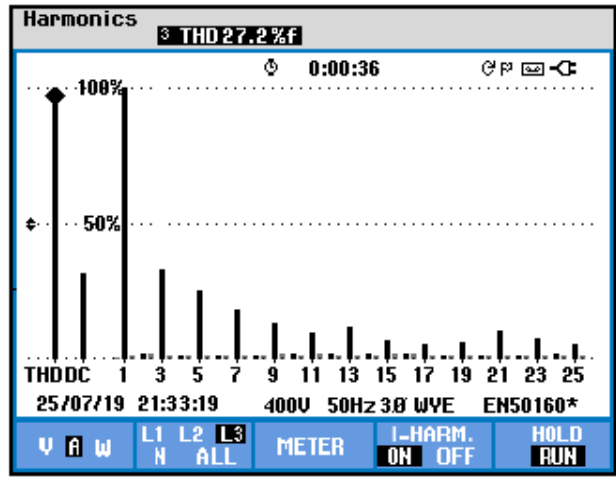
Figure 13. THD level of source current before connecting the solar photovoltaic supported QZSI-unified power quality conditioner.